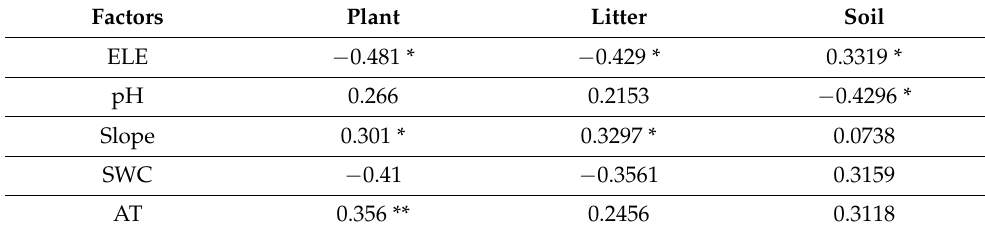
Figure 3. ( A – E ) Fitting results of structural equation model for plant, litter, soil and environmental factors. Note: The explicit variable of the structural equation and the number on the line point to the path coefficient; blue represents positive correlation; red represents negative correlation; AT: Air temperature; SWC: Soil water content; ELE: Elevation; PCN: Plant C:N; PCP: Plant C:P; PNP: Plant N:P; LCN: Litter C:N; LCP: Litter C:P; LNP: Litter N:P; SCN: Soil C:N; SCP: Soil C:P; SNP: Soil N:P. Table 2. The influence coefficient of the observed variable (environment) to latent variable (plant, litter and